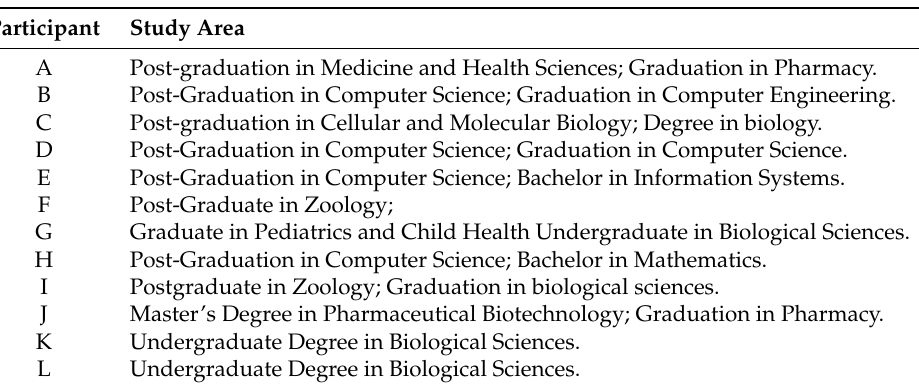
Table 8. Profile of